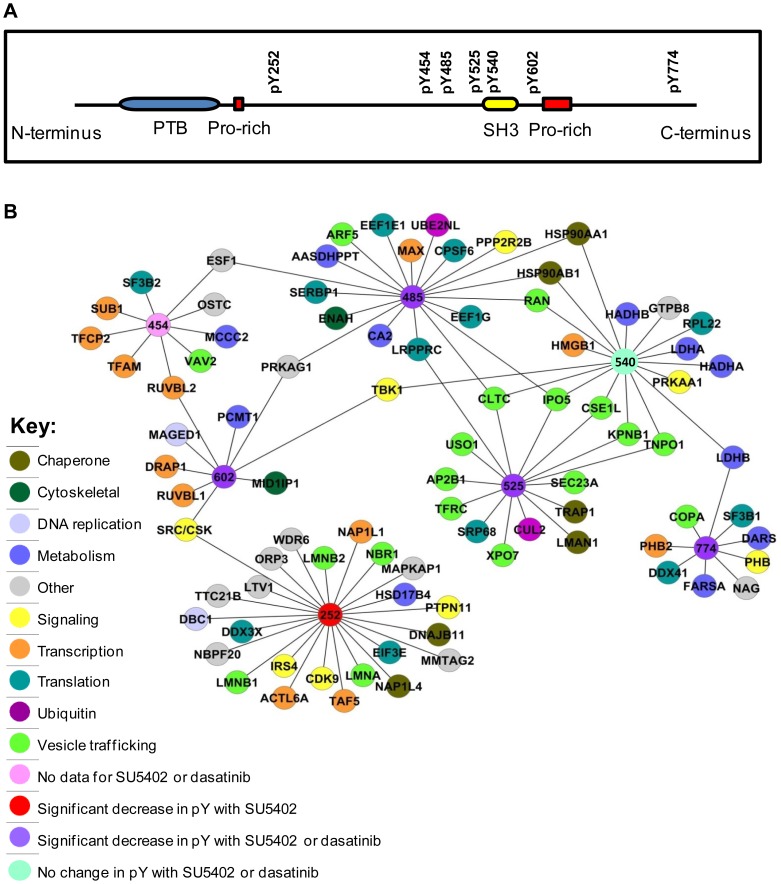
Protein-peptide interaction network for proteins binding specifically to phosphotyrosine-containing Eps8 peptides.A) Schematic diagram showing locations of the pY residues within the domain structure of Eps8. B) Using SILAC we carried out quantitative peptide pull-down assays from FGF2 stimulated (20 ng/ml; 15 min) HEK 293T cells to compare protein-peptide interactions for phosphotyrosine versus non-phosphotyrosine containing Eps8 peptides. Proteins interacting preferentially to phosphotyrosine peptides have been plotted in an interaction network.